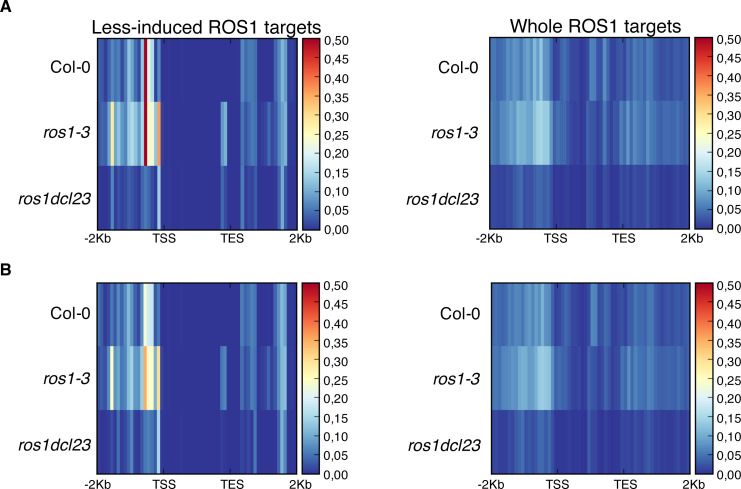
Analysis of 23–24 nt siRNA levels for the groups of 102 less-induced genes and 2943 genes carrying hyperDMRs in the ros1-3 mutant background.(A) Heatmaps depicting 23nt- and 24nt-long siRNA levels at the 102 less-induced genes (left panel) and at the 2943 genes presenting hyperDMR in ros1-3 (right panel) on replicate 1. Global siRNA levels were quantified from 2 Kb upstream sequence from the TSS, the gene body, and 2 Kb downstream sequence of the TES of genes in 5-week-old rosette leaves in non-treated Col-0, ros1-3, and ros1dcl23. (B) Heatmaps depicting 23nt- and 24nt-long siRNA levels at the 102 less-induced genes (left panel) and at the 2943 genes presenting hyperDMR in ros1-3 (right panel) on replicate 2. Global siRNA levels were quantified from 2 Kb upstream sequence from the transcription start site (TSS), the gene body, and 2 Kb downstream sequence of the TES of genes in 5-week-old rosette leaves in non-treated Col-0, ros1-3, and ros1dcl23.